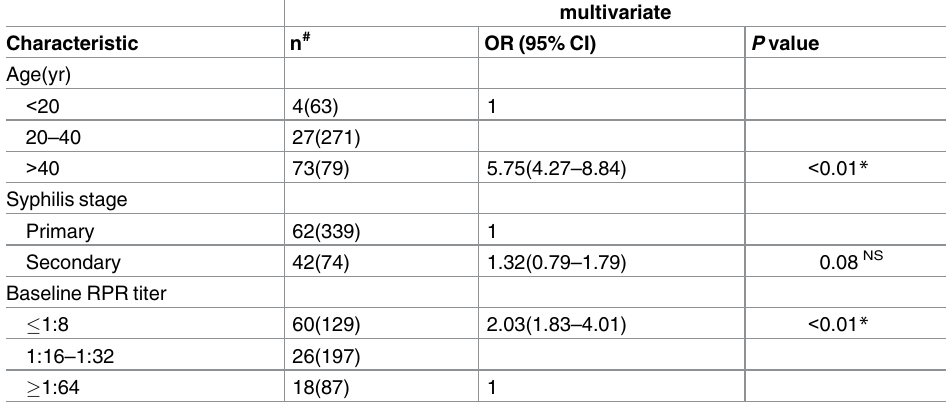
Table 3. Multivariate analysis of factors associated with